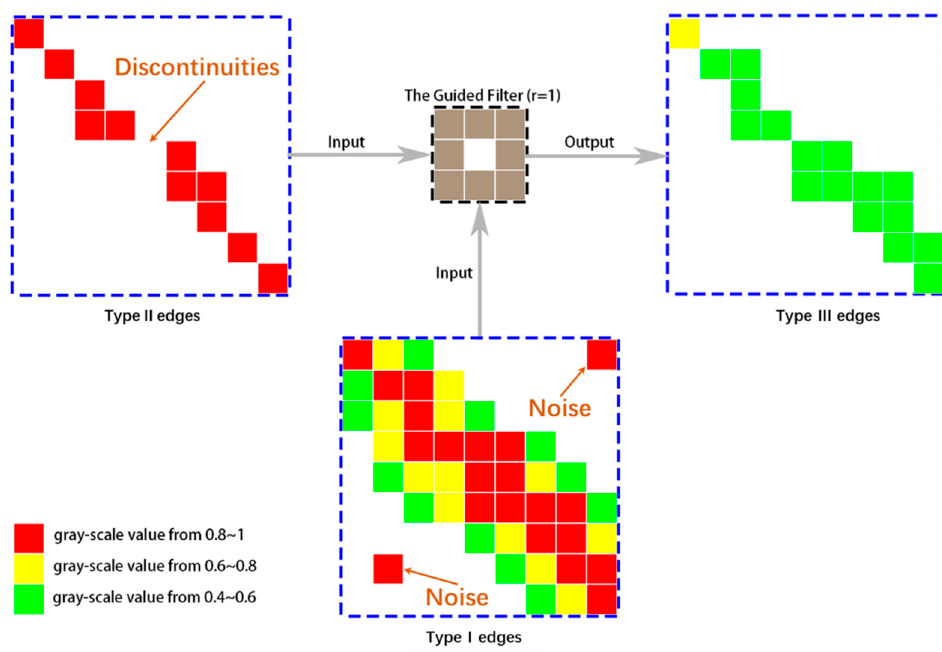
Figure 4. The operation procedure of the guided filter.